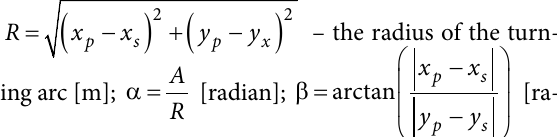
Fig. 2c, q = α + b [radian].